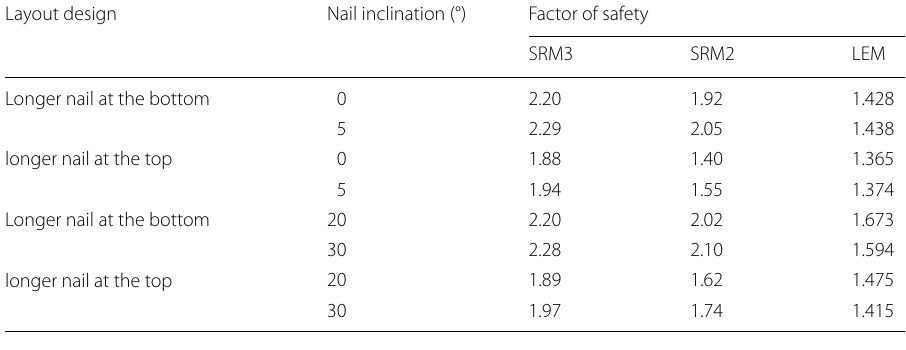
Table 6 FOS values under different soil nail layout Layout design